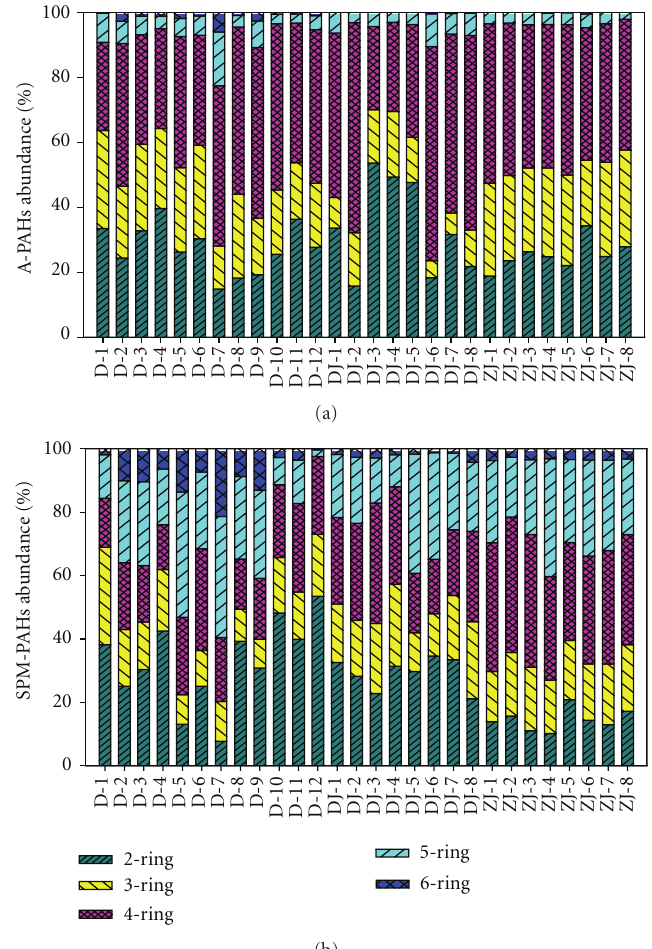
Figure 5: The composition of PAHs in (a) water samples and (b) suspended particular matters samples (both except for Nap and Phe).